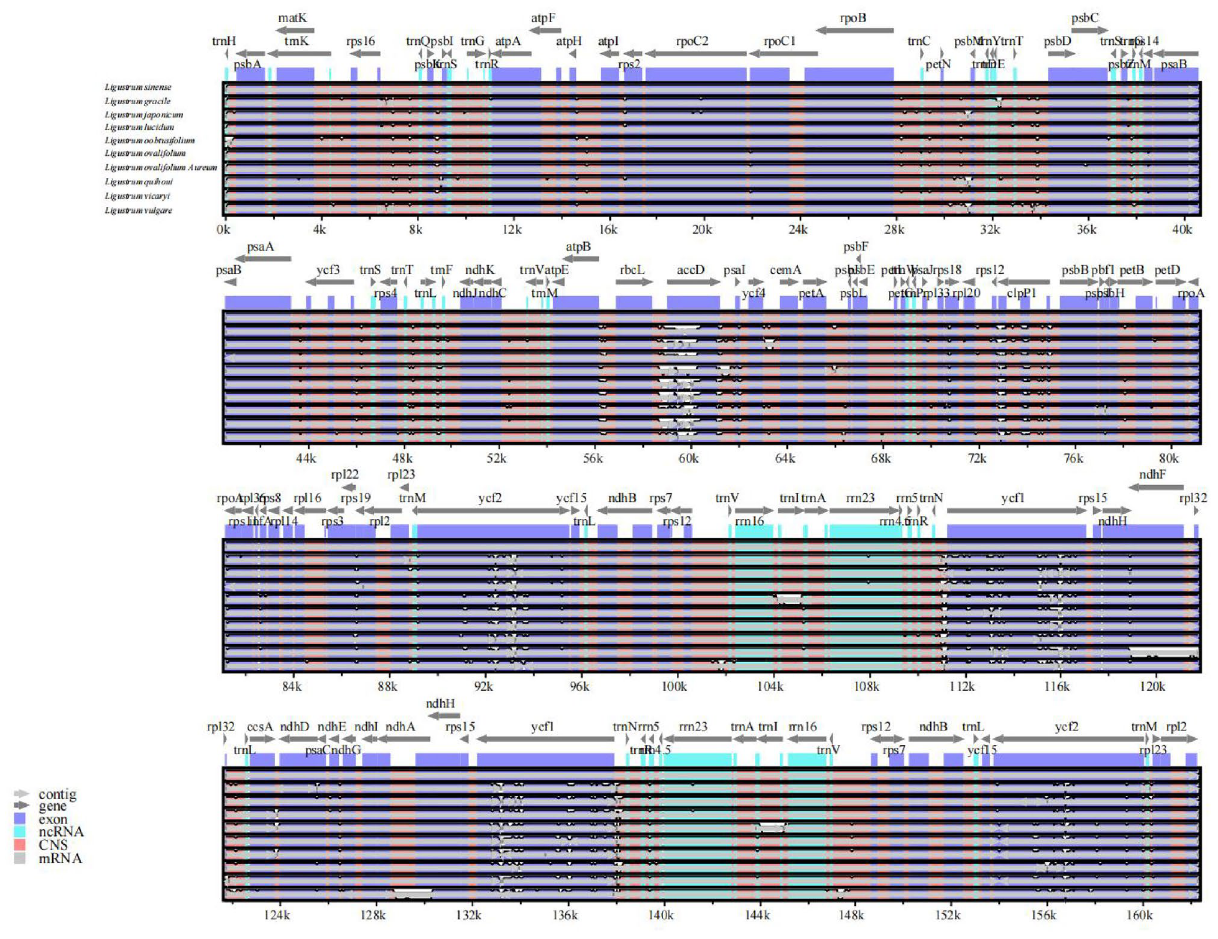
Figure 6. Comparison of ten Ligustrum chloroplast genomes using mVISTA, with the L.sinense genome as the reference. The y-axis represents the percent identity within 50–100%. Gray arrows indicate the direction of gene transcription. Blue blocks indicate conserved genes, while red blocks indicate conserved noncoding sequences